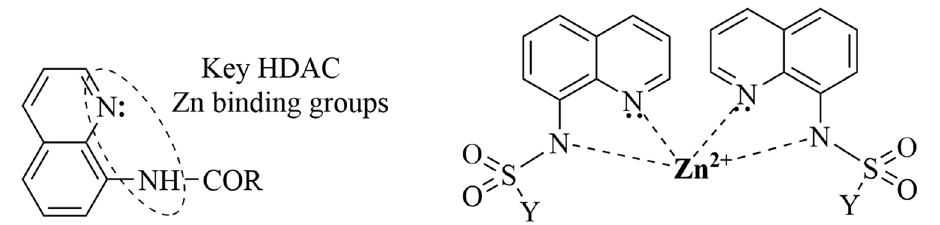
Figure 2. HDAC inhibitors and zinc complexes of 8-aminiquinoline